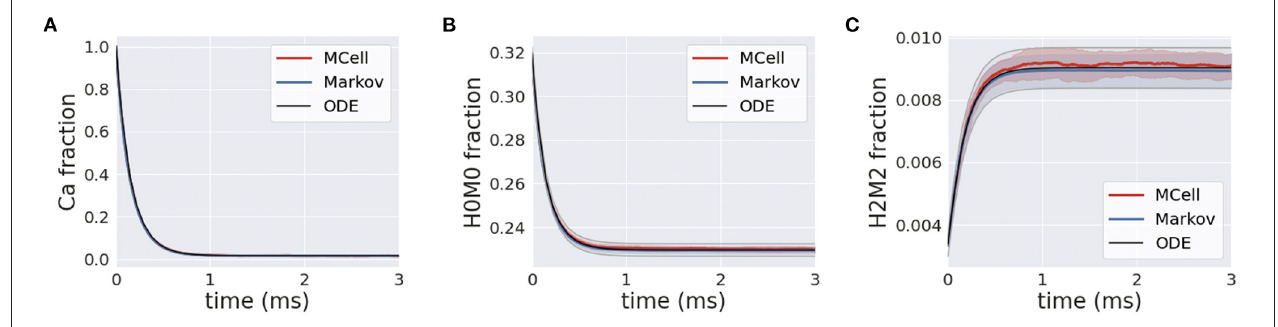
FIGURE 7 | (A) Transients for homogeneous calcium-calbindin buffer binding in the presynaptic bouton for free calcium; (B) the unbound calbindin state, H0M0; and (C) the fully bound calbindin state, H2M2 in all simulation types.